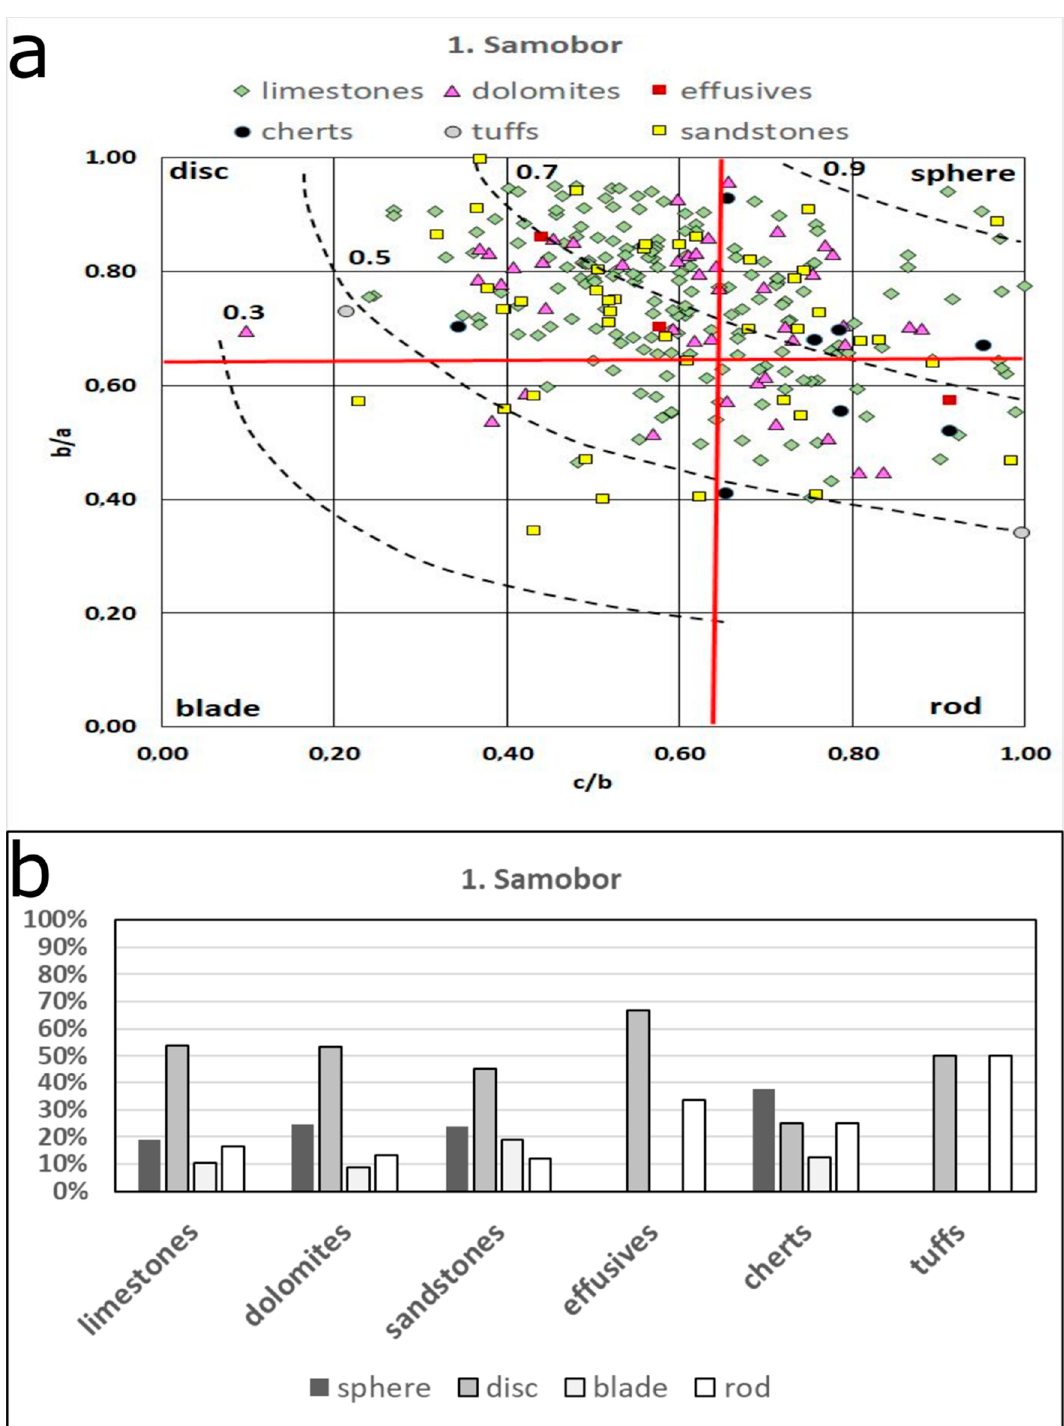
Figure 7. Pebble shapes of main lithotypes in Samobor: ( a ) Zingg diagram; ( b ) histograms.